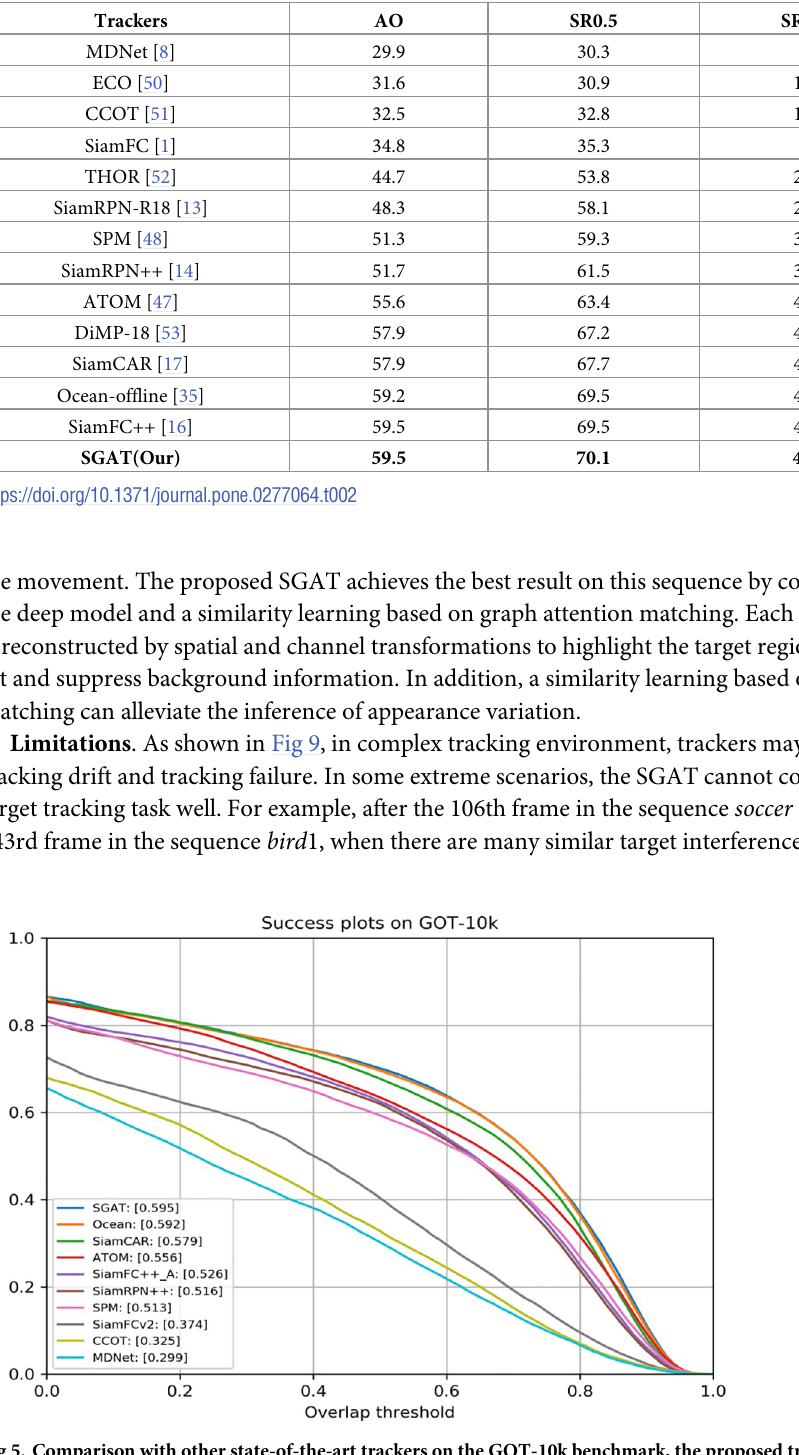
Table 2. Comparison with state-of-the-art trackers on GOT-10k benchmark. AO, success rates(SR)0.5 and success rates(SR)0.75 represent the average overlap and the success rate at the threshold of 0.5 and 0.75.